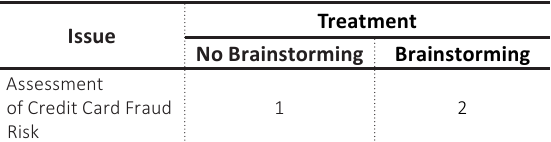
Table 1. Factorial